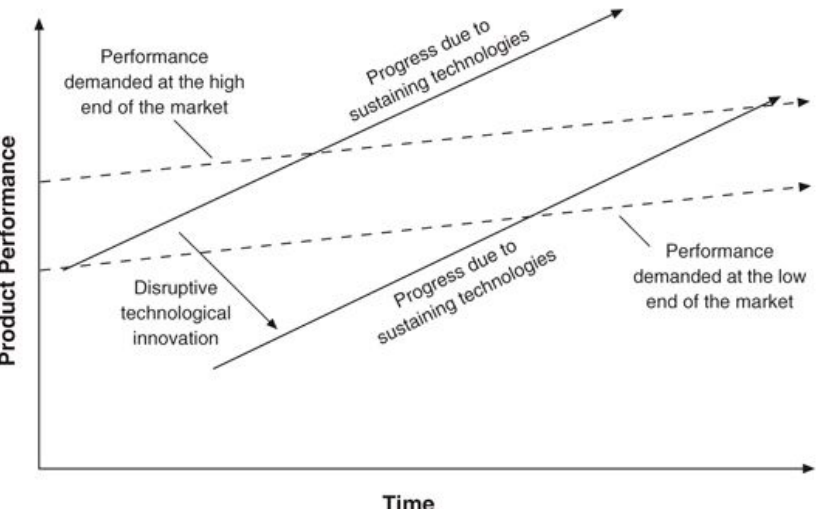
Figure 1. Christensen’s model of disruption (Bower and Christensen (1995)).